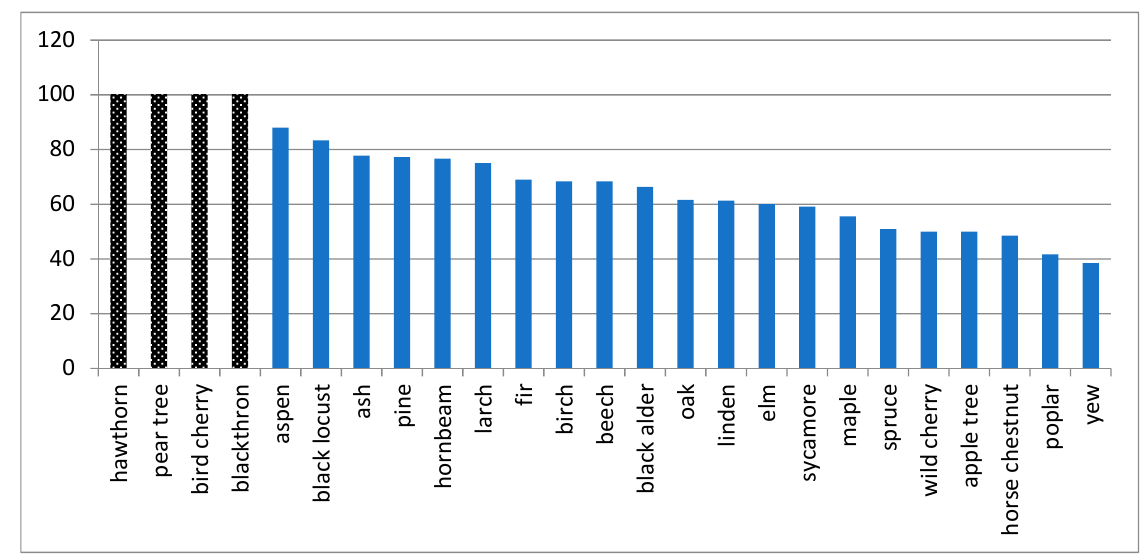
Figure 1. Frequency of Uropodina mites in dead wood samples of examined tree species. The first four tree species with 100% frequency had very low number of samples.